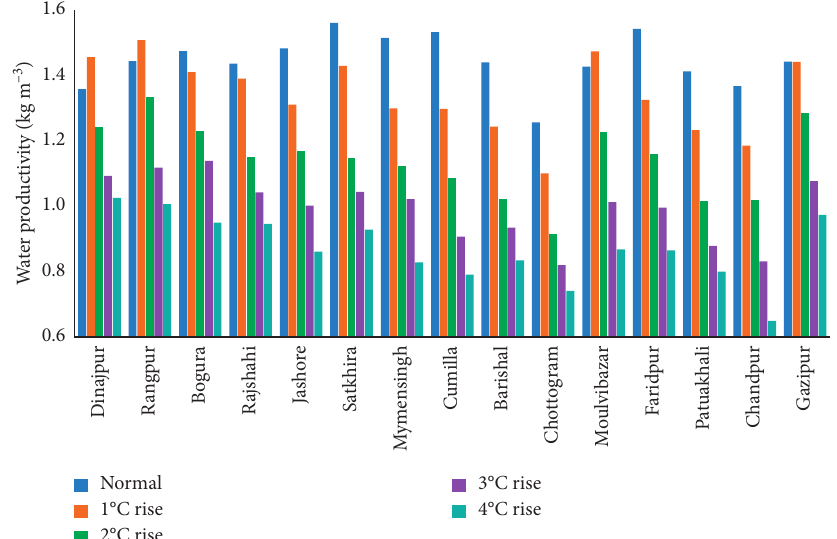
Figure 6: Actual water productivity of rice under elevated temperature in the study